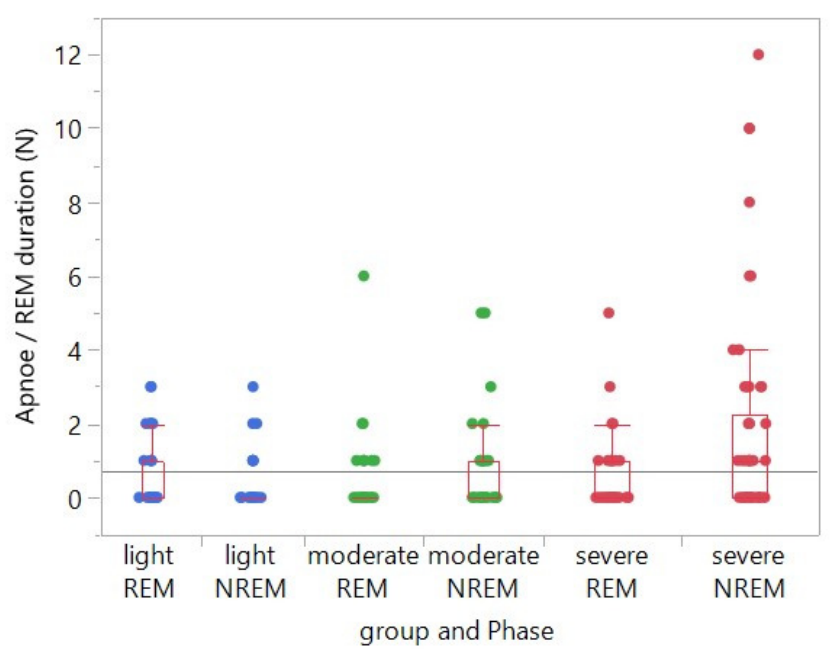
Figure 1. Single factorial analysis of the number of central apneic events (CAEs) in relation to the respective REM sleep duration by group (severity of OSA: mild, moderate, severe) and sleep phase (REM, NREM). In the group of severely affected OSA patients, the frequency of CAEs was significantly increased in the NREM phase when compared to the one in the REM phase, when adjusted for the duration of the REM phase. This was not the case in the group of moderately and mildly affected OSA patients. The symbols overlap in many cases, and most data points were at the value 0. Unfortunately, it is difficult to present this clearly without distorting the intended message of the plot. Due to the overlay, not all data points are clearly visible.